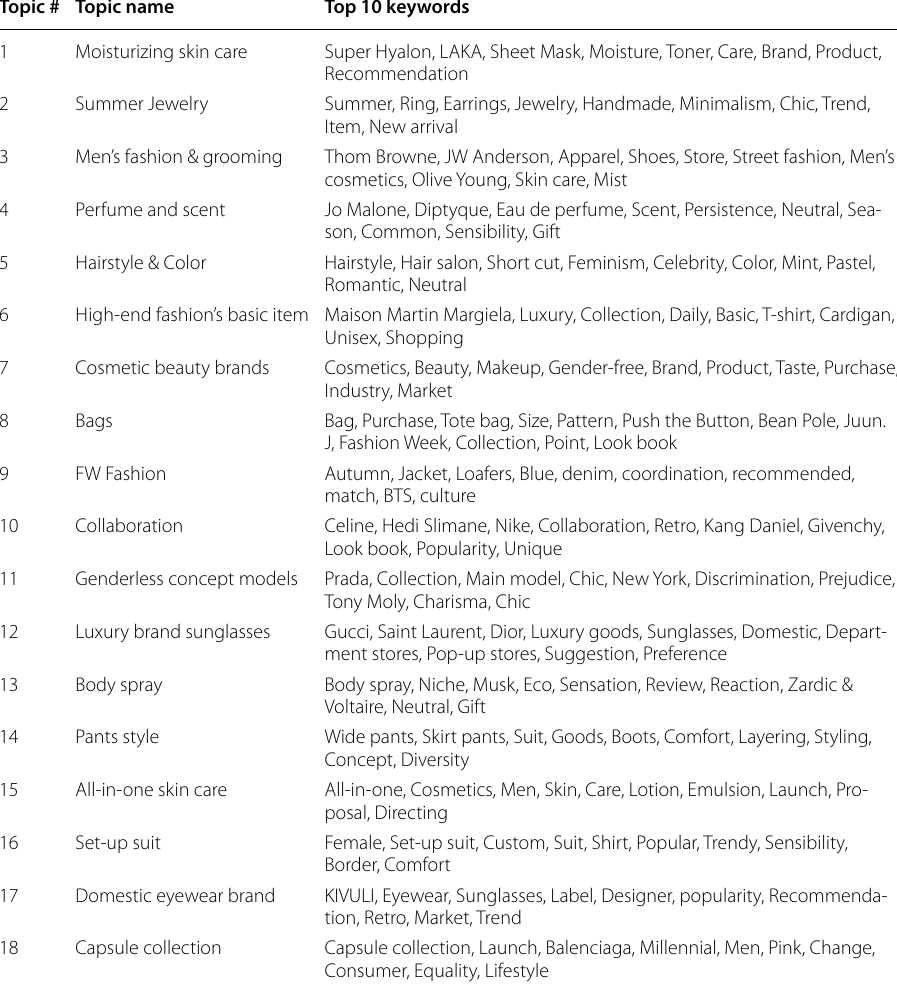
Table 3 Topic modeling analysis result about the genderless